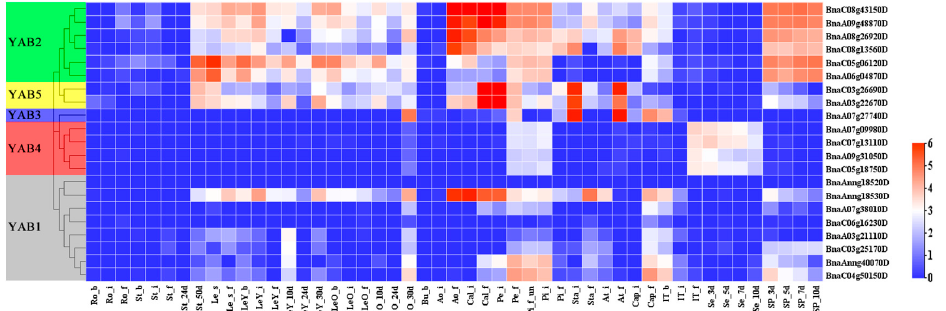
Figure 6. Heatmap representation of the expression patterns of BnaYAB genes in the ZS11 cultivar. The abbreviations below the heatmap indicate the different tissues and organs/developmental stages (Table S6) relative expression is shown as a heatmap (Table S7).